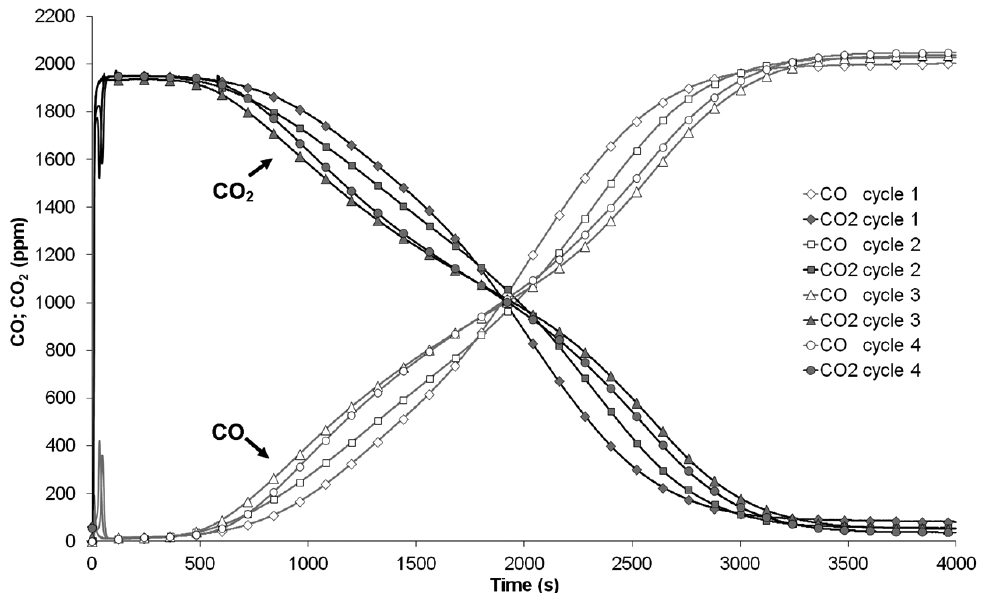
Figure 4. Reduction cycles of 0.28g of NiO/NiAl